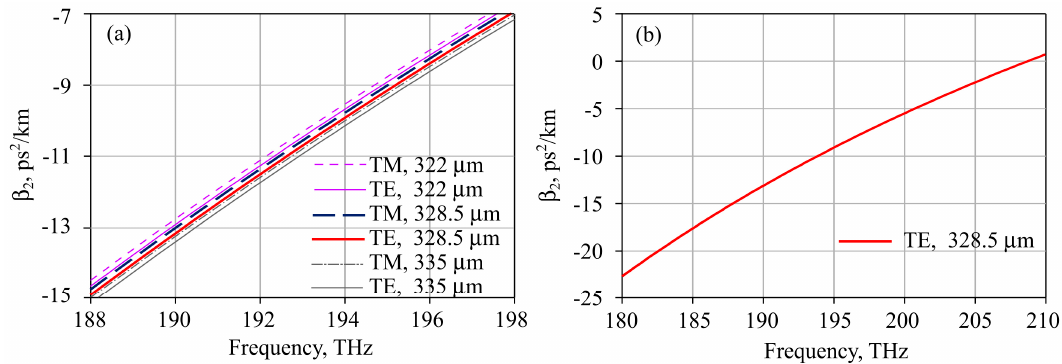
Figure 4. ( a ) Dispersion as a function of frequency for microspheres with indicated diameters for TE and TM modes. ( b ) Dispersion as a function of frequency for a microsphere with a diameter of 328.5 µ m for TE modes.